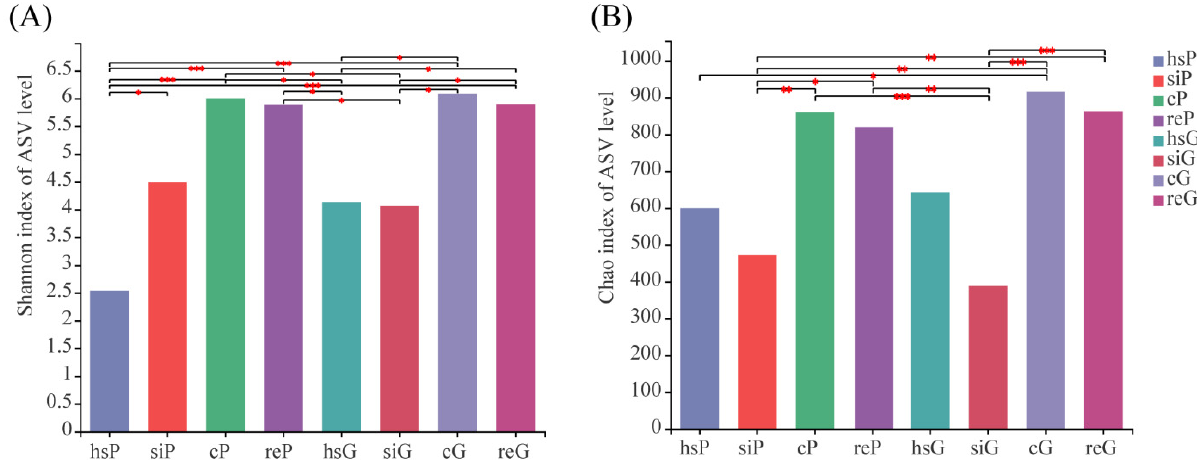
Figure 2. Alpha diversity analysis: ( A ) Shannon index and ( B ) Chao index. * 0.01 < p ≤ 0.05; ** 0.001 < p ≤ 0.01; *** p ≤ 0.001. P represents the plateau zokor and G represents the Gansu zokor. The stomach, small intestine, cecum, and rectum of the plateau zokor (the Gansu zokor) are labeled as hsP, siP, cP, and reP (hsG, siG, cG, and reG), respectively.